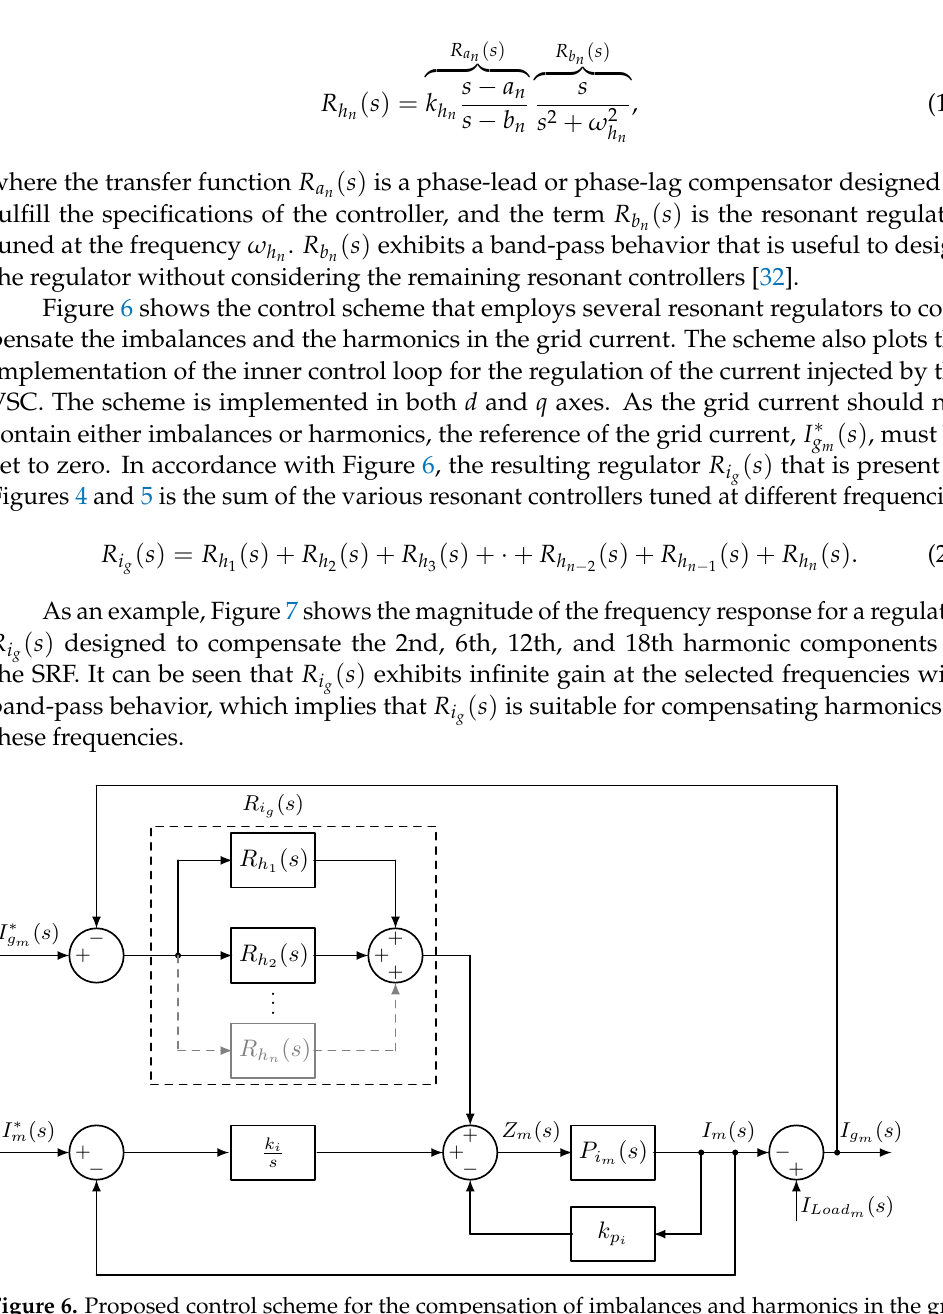
Figure 6. Proposed control scheme for the compensation of imbalances and harmonics in the grid current together with the inner control loop for the control of the current injected by the